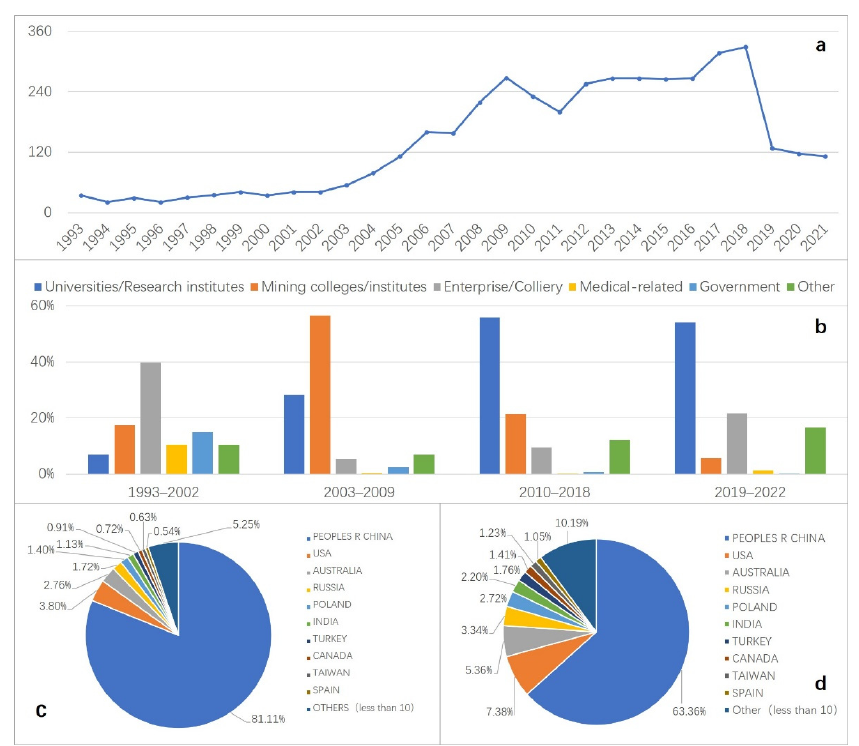
Figure 4. Author distributions ( a ) number of new authors per year, ( b ) distribution of new authors by institution, ( c ) distribution of all authors for both Chinese and English-language papers, ( d ) distribution of authors by nationality for English papers).